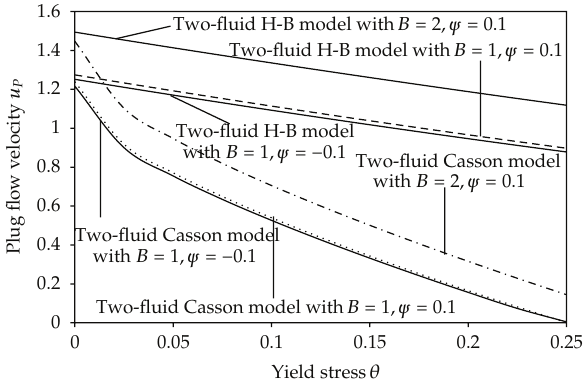
Figure 4: Variation of plug flow velocity with yield stress for two-fluid H-B and Casson fluid models and di ff erent values of B and ψ with b (cid:7) 0 . 1, β (cid:7) 0 . 95, t (cid:7) 60 ◦ , δ P (cid:7) 0 . 1, e (cid:7) 0 . 5, φ (cid:7) α H (cid:7) α C (cid:7) 0 . 2, ω (cid:7) 1, z (cid:7) 2 . 3 and β (cid:7) n (cid:7) 0 .